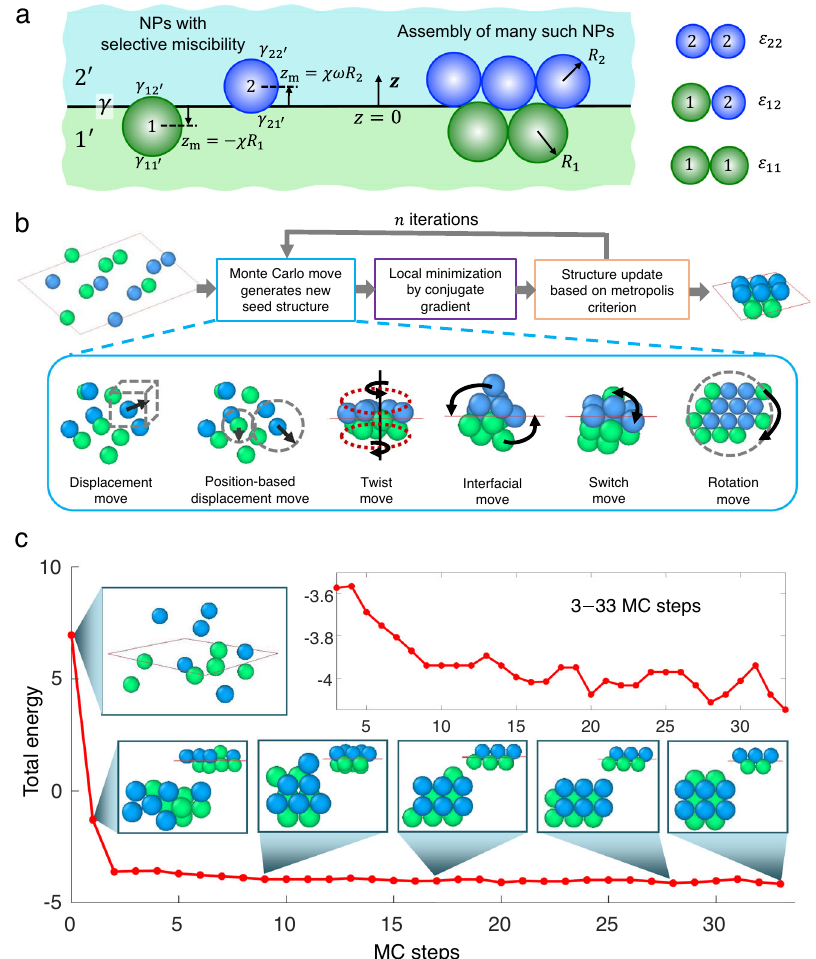
Fig. 1 | Global optimization approach for exploring NP structures formed at fl uid interfaces. a Schematic of the model system comprised of two species of surface-functionalized NPs assembling in a fl uid- fl uid bilayer and the parameters used for describing its free energy. b Simpli fi ed fl ow chart of our tailored BHMC algorithm highlighting the MC moves we implemented to improve performance. c Optimizationoutcomeforabinary6:6systemofNPs( φ =1, ϵ =0 : 08, χ =0 : 6, ω =1)